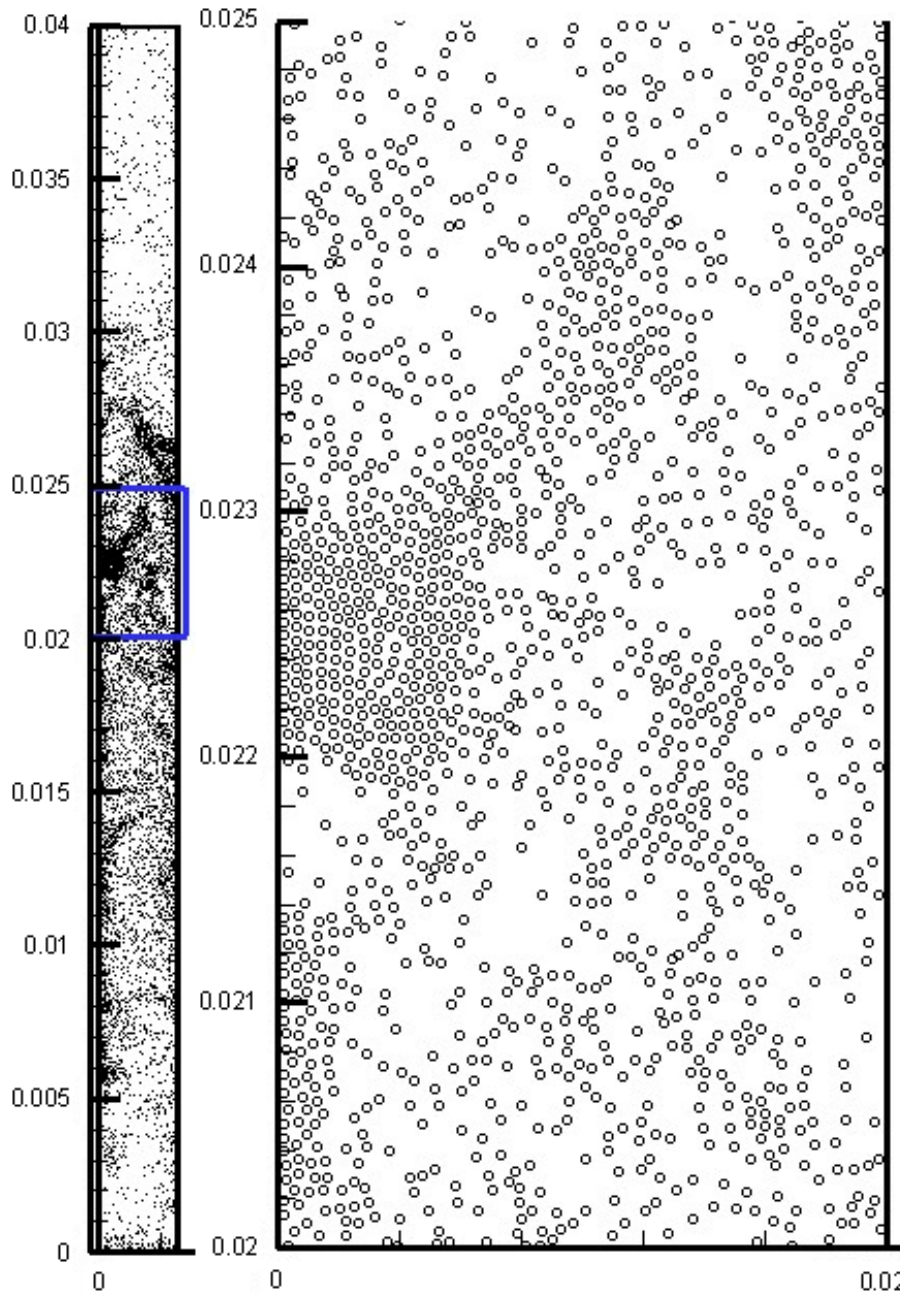
 t . Figure 5. Particle locations at 0.381 s, with moderate t r = r